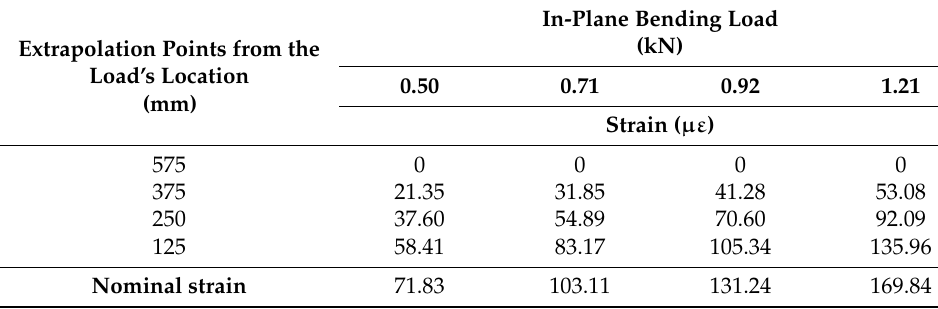
Figure 4. Determination of hot spot strains using quadratic extrapolation. Table 2. Experimental nominal strains of specimen S6S4 under in-plane bending.